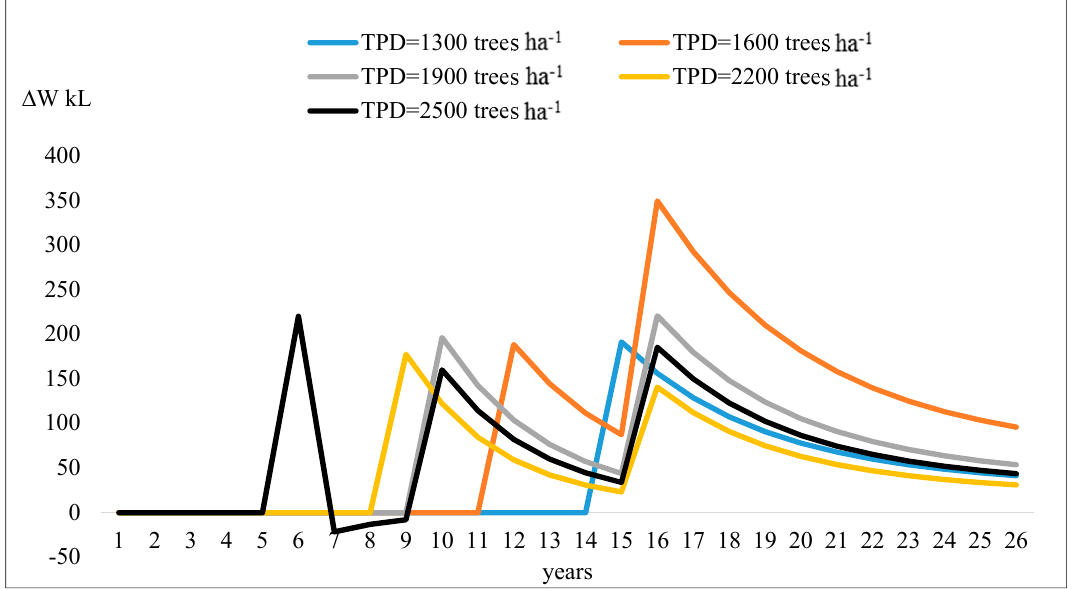
Figure 2. Variation of water yield ( ∆ W ) for different tree planting densities (TPD).